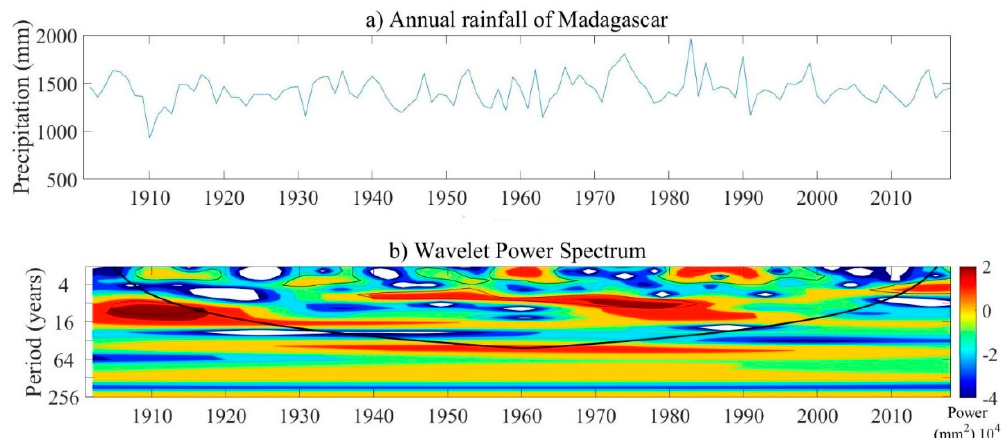
Figure 4. ( a ) Annual average rainfall and ( b ) Wavelet analysis of the annual rainfall of Madagascar. The thick black contour designates the 95% confidence level against red noise. The cone of influence (COI) where edge effects might distort is shown as the U-shape